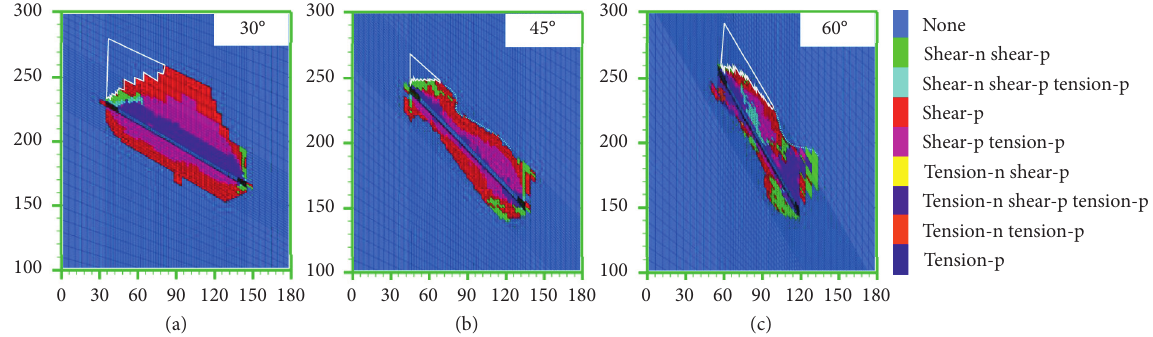
Figure 9: Distribution characteristics of the plastic zone in coal seam with different dip angles.